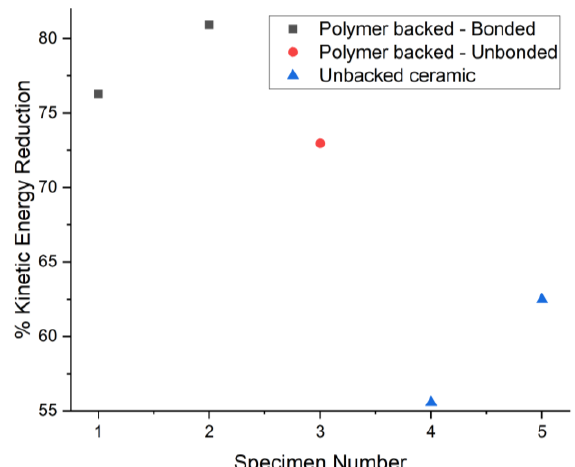
Fig 7. Percentage kinetic energy reduction during impact, calculated using image tracking, comparing across specimen conditions.